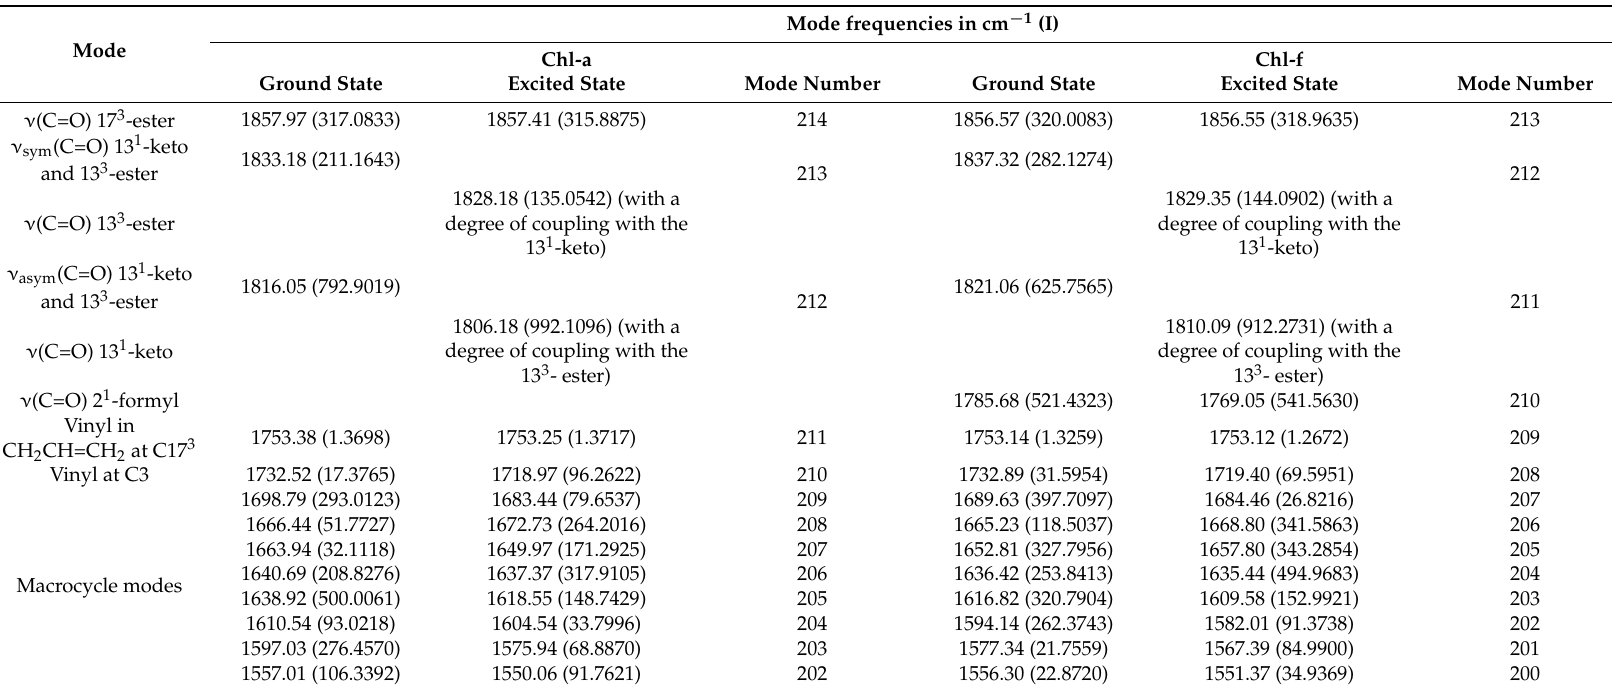
Table 1. Vibrational mode frequencies (unscaled) calculated for ground state and excited state chlorophylls a and f using the CAM-B3LYP method and 6-31G(d) basis set, with corresponding mode assignments. Intensities (in km/mol) are shown in